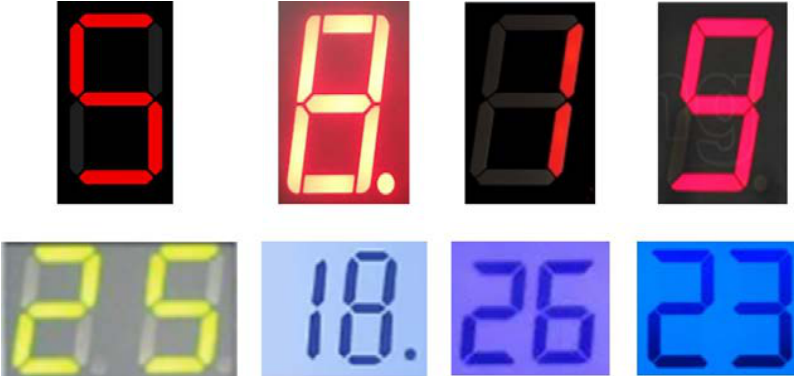
Figure 10. Eight examples of digit detection results.